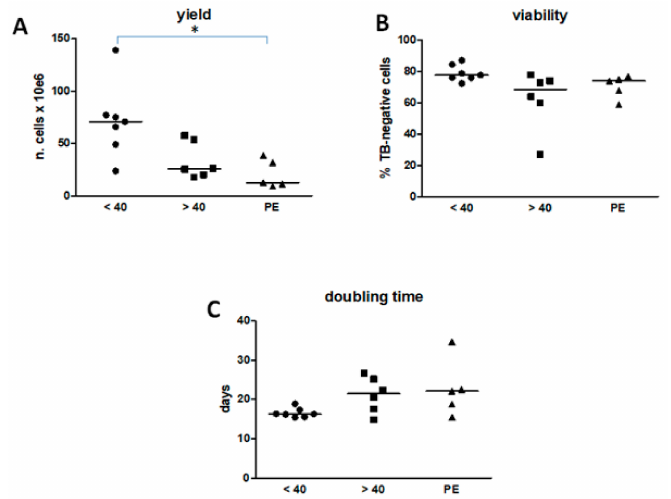
Figure 1. Yield, viability and doubling time of human amnion-derived mesenchymal stromal cells (hAMSCs). ( A ) The yield refers to the same area of amniotic membrane (5 cm 2 ) for each group. ( B ) The viability refers to the percentage of cells which have excluded the trypan blue (TB). ( C ) The doubling time refers to cells grown from p0 to p5. In (A) * P < 0.05 of Group 3 vs. Group 1. Results are shown as individual values and median as a straight line, within each Group (Group 1, n = 7; Group 2, n = 6; Group 3, n =